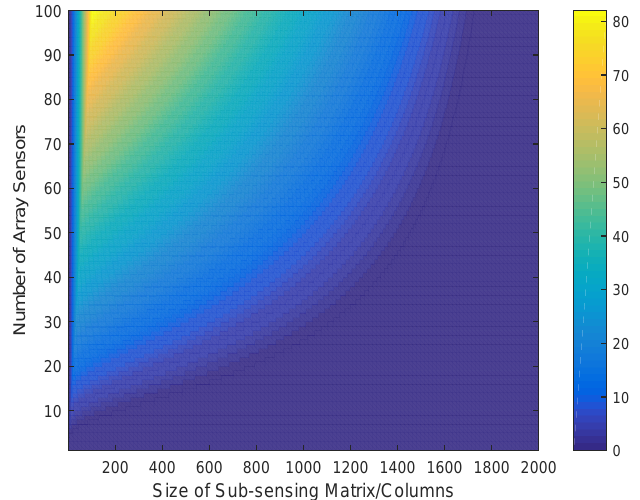
Figure 2. The number of smaller singular values of the sensing matrix with different weight widths versus array sensor